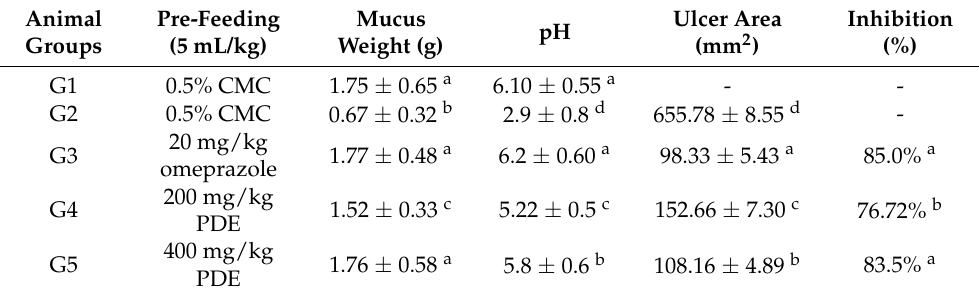
Figure 2. Histological portions of the kidney and liver of rats tested for acute toxicity. Rats administered with 5 mL/kg of the vehicle (0.5% CMC) ( A , B ). Rats administered with the PDE, 200 mg/kg ( C , D ). Rats administered with the PDE, 400 g/kg ( E , F ). No significant changes were observed in the structures of the livers and kidneys between the treated and control groups (H & E staining, 40×). Table 1. Protective effects of P. decaisnei on some stomach parameters of the rats with ethanol-induced gastric